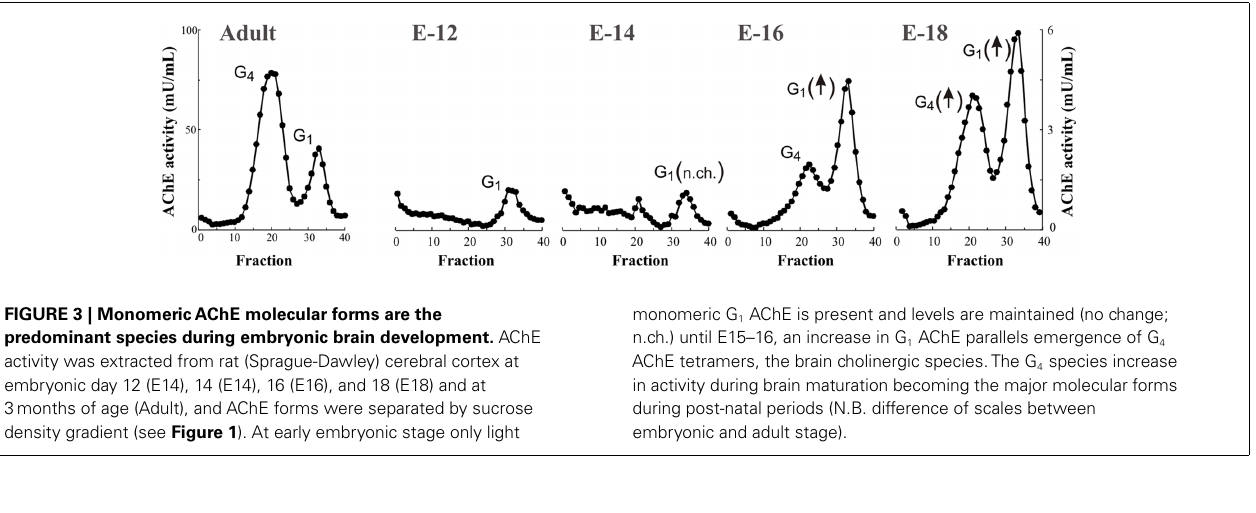
monomeric G 1 AChE is present and levels are maintained (no change; n.ch.) until E15–16, an increase in G 1 AChE parallels emergence of G 4 AChE tetramers, the brain cholinergic species.The G 4 species increase in activity during brain maturation becoming the major molecular forms during post-natal periods (N.B. difference of scales between embryonic and adult